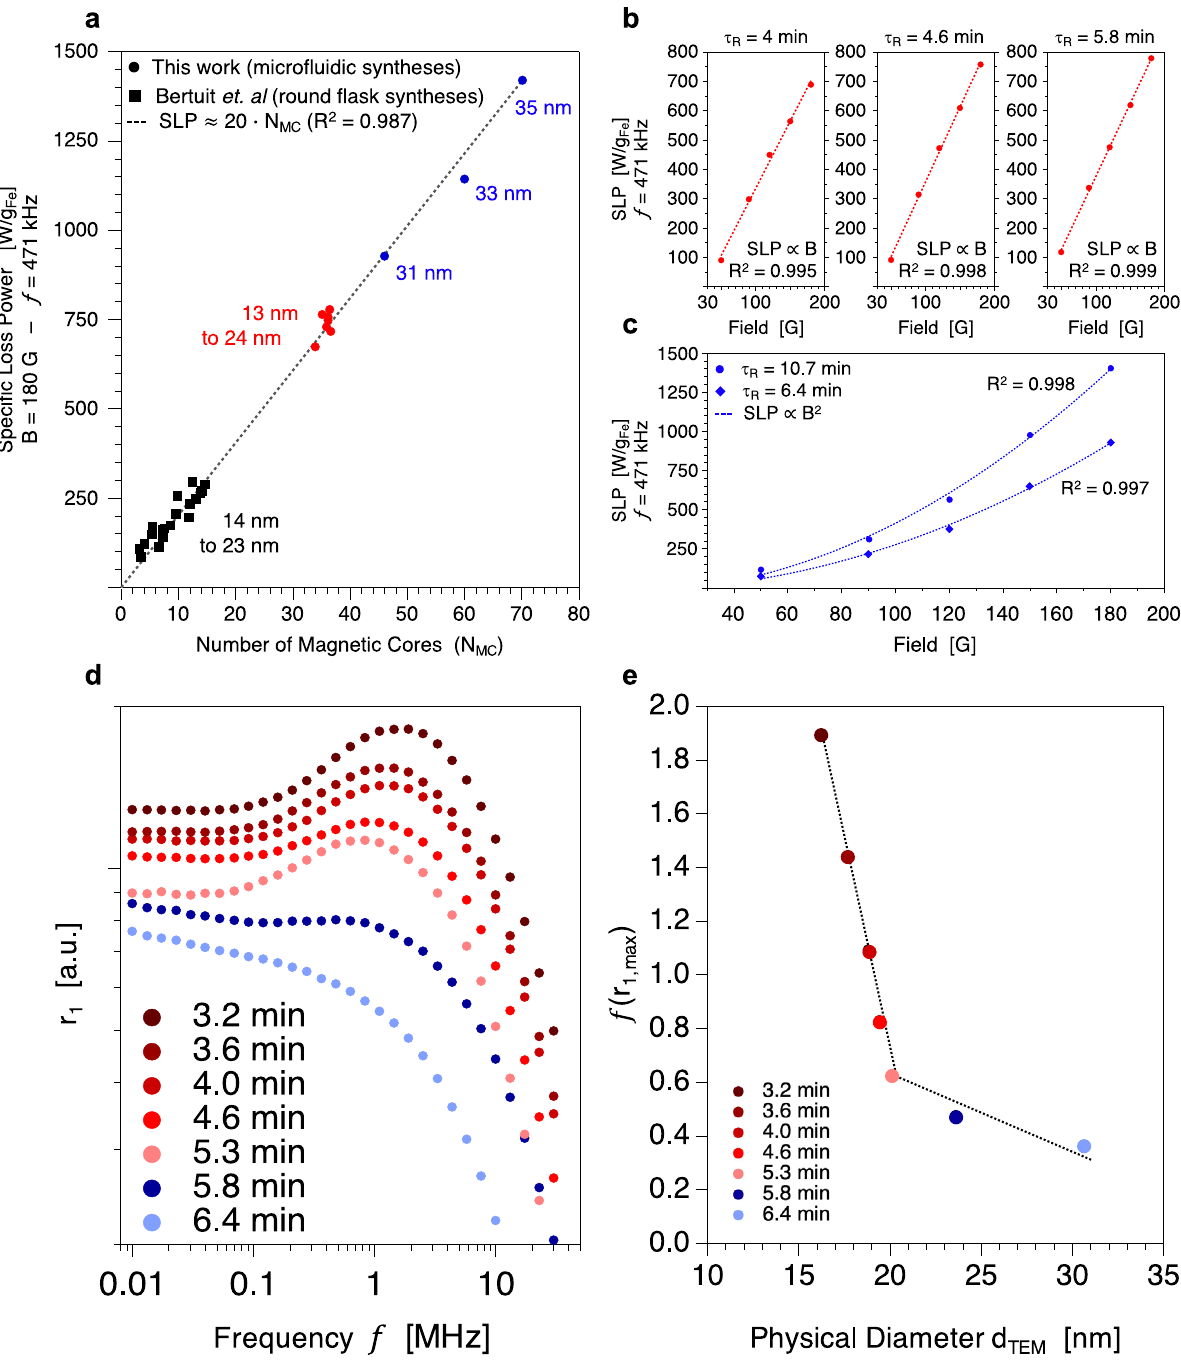
Fig. 3 NFs dynamic magnetic properties: magnetic hyperthermia and longitudinal relaxivity pro fi les. a SLP as a function of number of magnetic cores and comparison with previous work for an AMF of 180 G and 471 kHz. b , c SLP as a function of AMF strength at a fi xed frequency of 471 kHz for residence times of 4, 4.6, 5.8 min and 6.4, 10.7 min. d r 1 longitudinal relaxivity pro fi les for different residence times. e Frequency position f of the maximum r 1,max as a function of physical